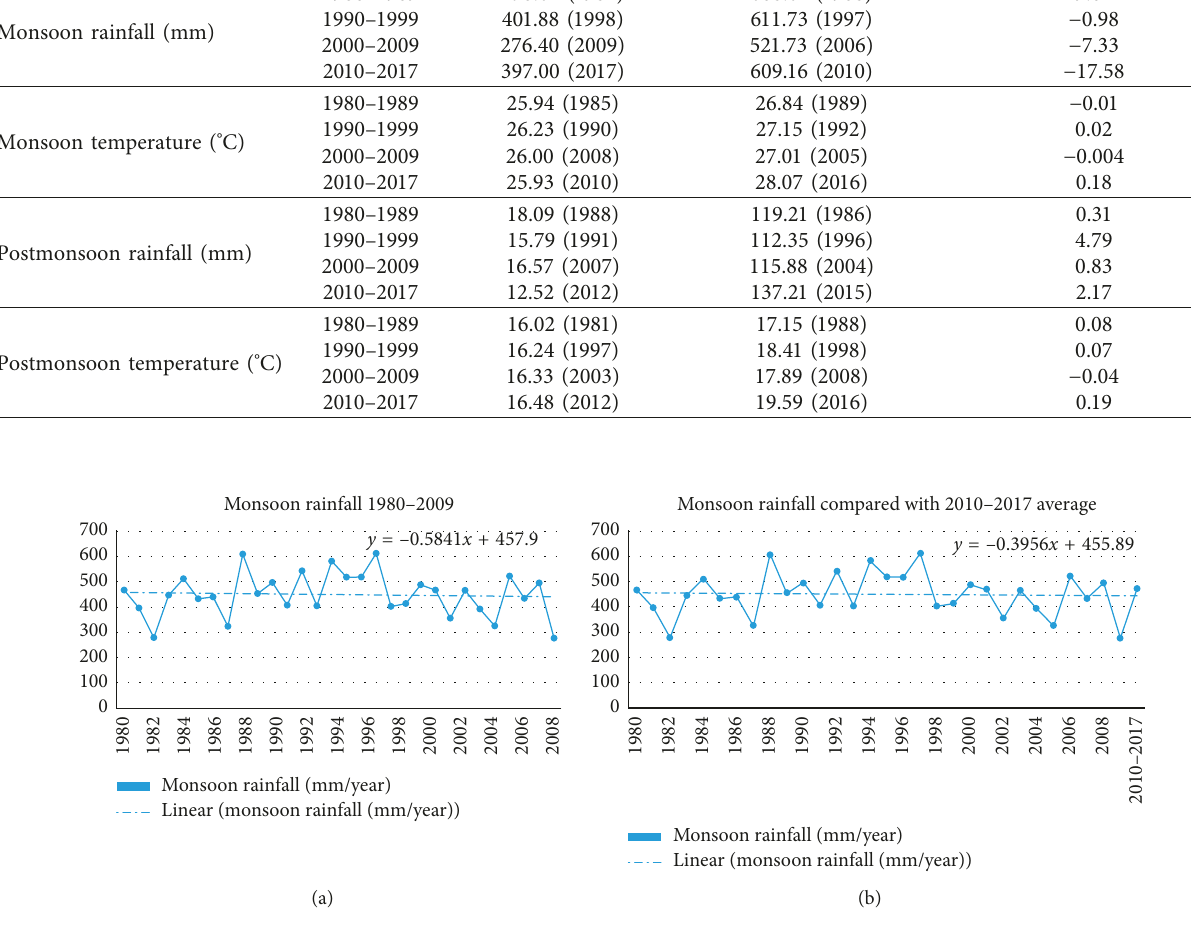
Figure 7: Long-term trend (1980–2009) for monsoon rainfall versus the long-term trend with the average of last 8 years (2010–2017). Both trends depict a decreasing trend in the monsoon rainfall, although 2010 was a year with anomalous high monsoon